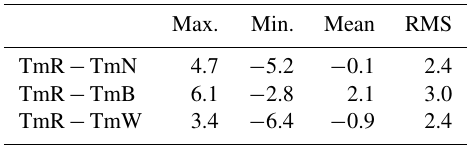
Table 2. Summary of the T m deviation between radiosonde-derived and model-derived ( K )